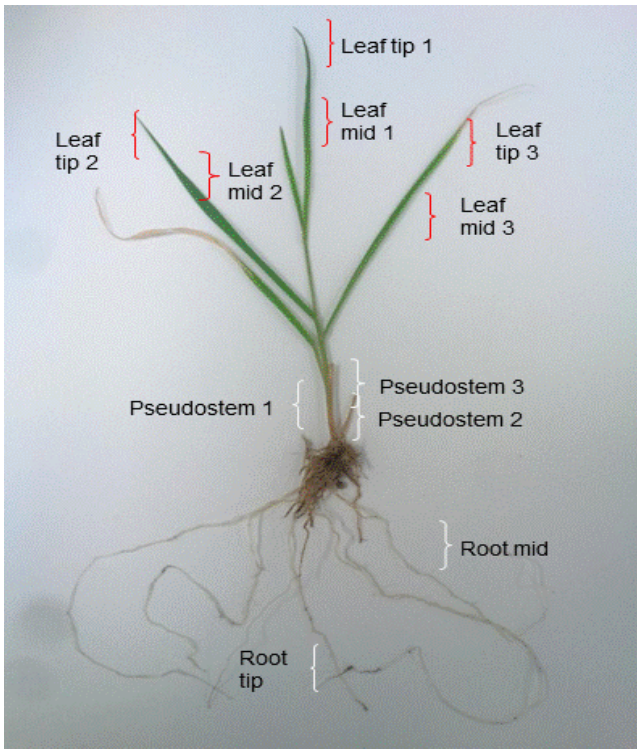
Figure 4. Pictorial representation and identification of the tissues of origin for vegetative sequencing